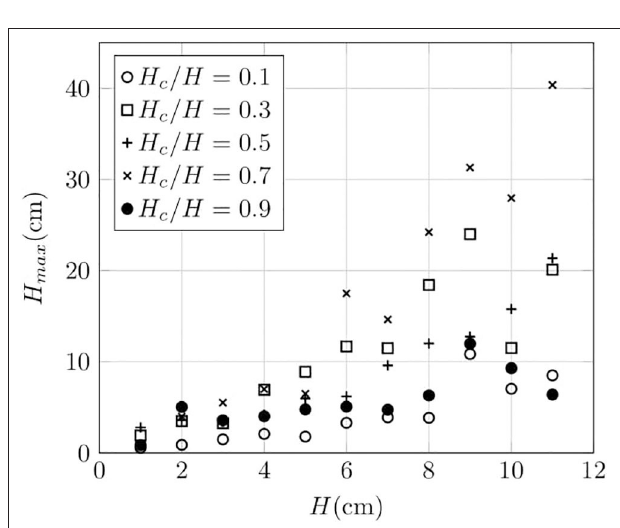
FIGURE 11 | Strength of breakthrough for a two-layer fluidised bed where H max is the maximum observed height of particles ejected from the bed. Heights were measured to an accuracy of ± 0.1cm. The bed consisted of a lower layer of particles with diameters 45–75 µ m particles and an upper layer of particles with a diameters 250–425 µ m where H c / H is kept constant over a range of H for five values of H c / H